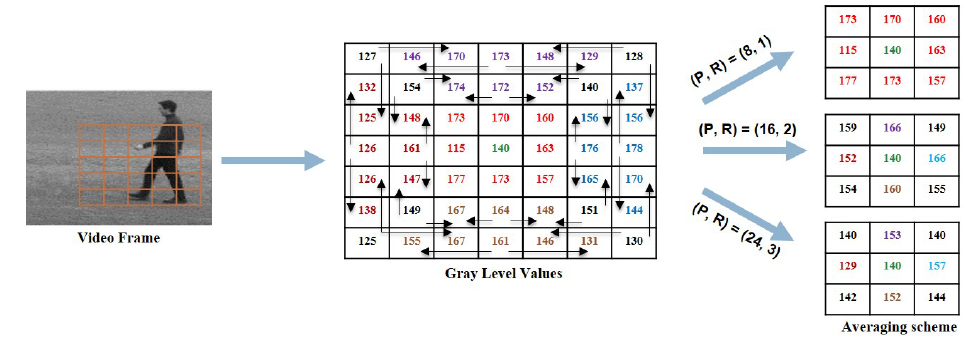
Figure 6. Averaging scheme for the multi-resolution